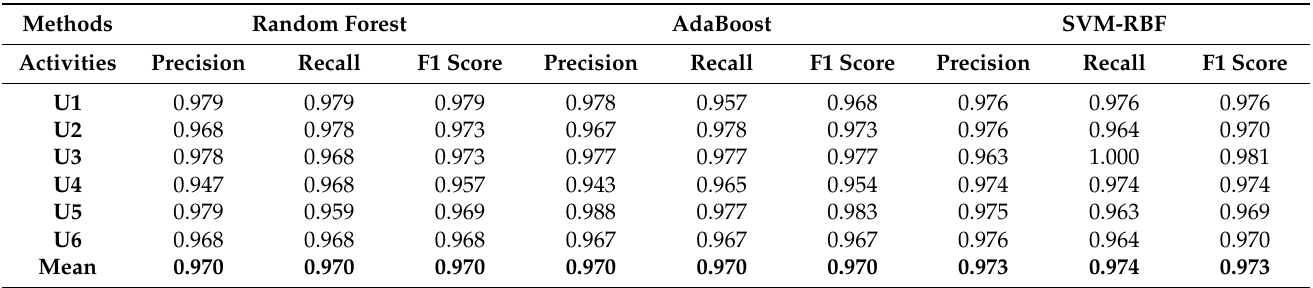
Table 5. Comparison of the evaluation metrics (precision, recall, and F1 score) of the HPAR model from the UCI-HAR dataset.